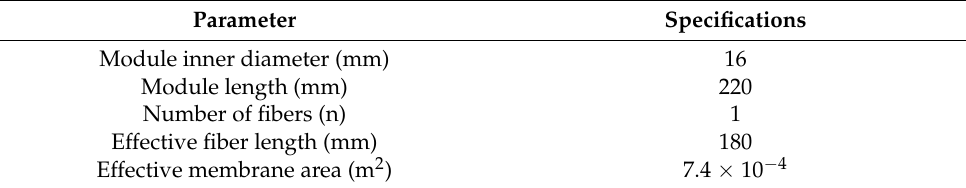
Table 2. Specifications of the membrane module for the membrane gas absorption